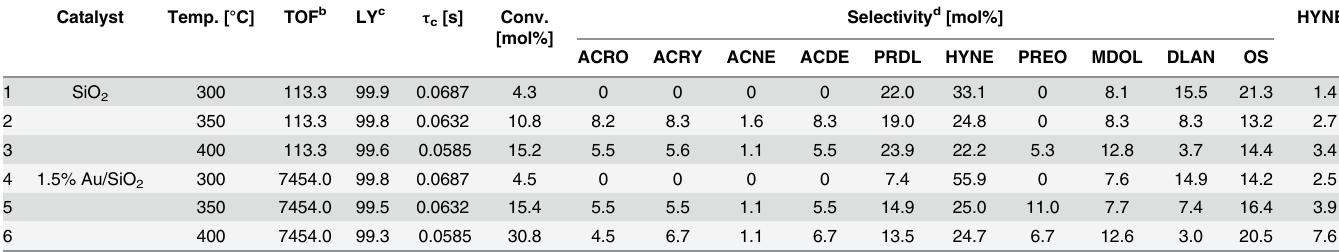
Table 3. Catalytic performance of SiO 2 -supported Au NPs in undiluted glycerol solutions at 300 – 400°C a . Catalyst Temp. [°C]